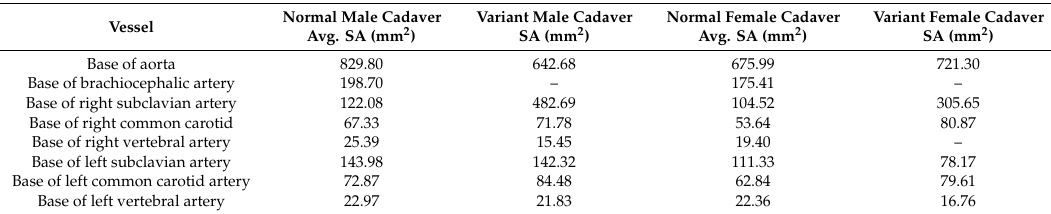
Table 1. Cadaveric data comparing the surface area (SA) of a variety of vessels in both normal and variant subjects of both